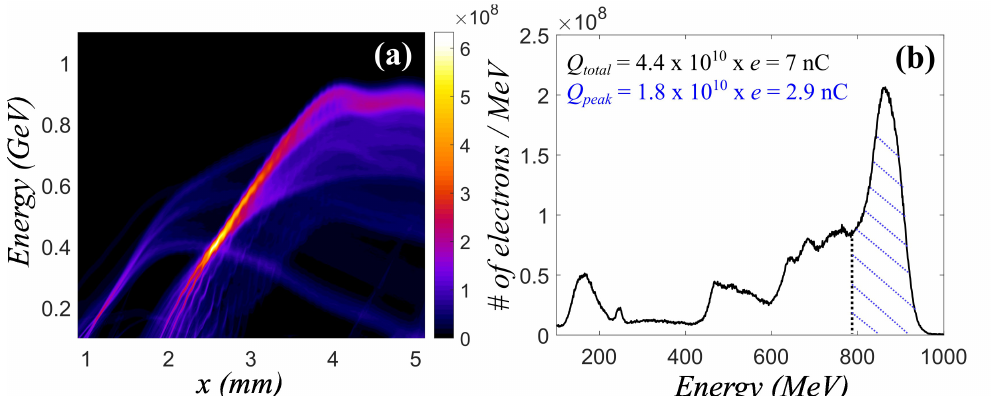
Figure 2. ( a ) Evolution of the electron spectrum inside the gas target. ( b ) Electron spectrum at the end of the gas target.